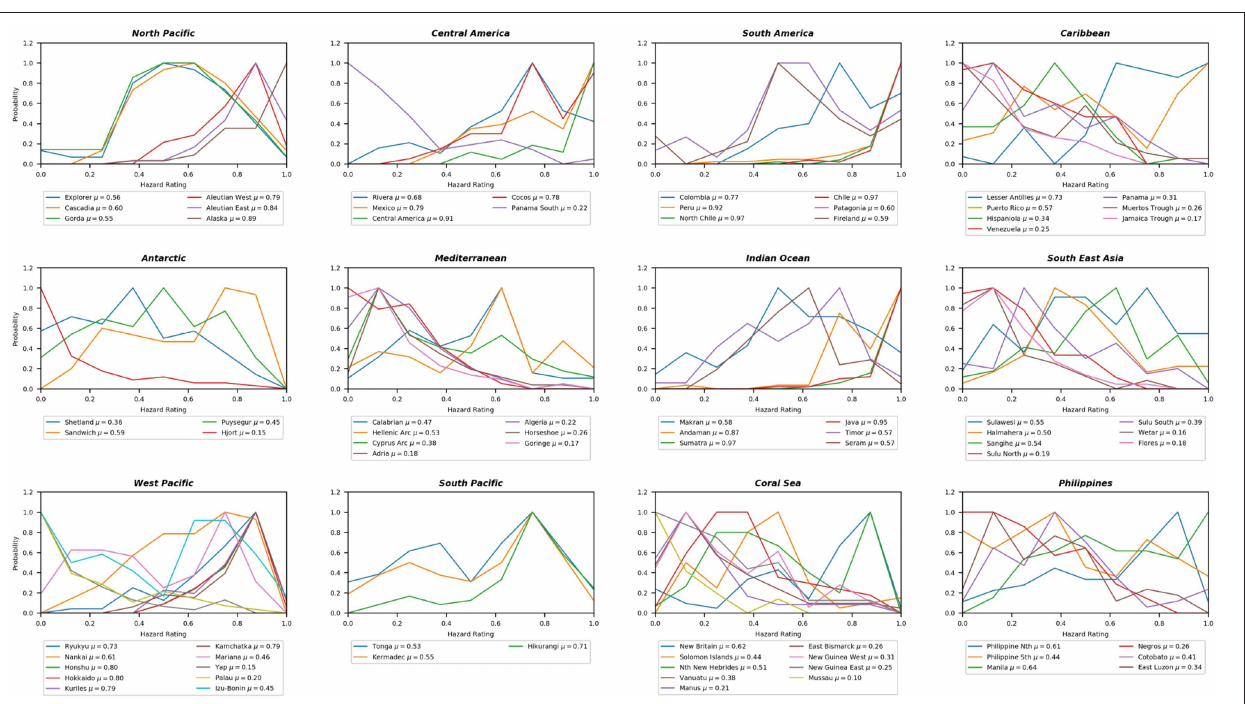
FIGURE 3 | Overview of all subduction zones split into different geographic regions. The graph shows the hazard rating probability. An increase of the hazard rating implies a stronger correlation with subduction zones of very large M h .